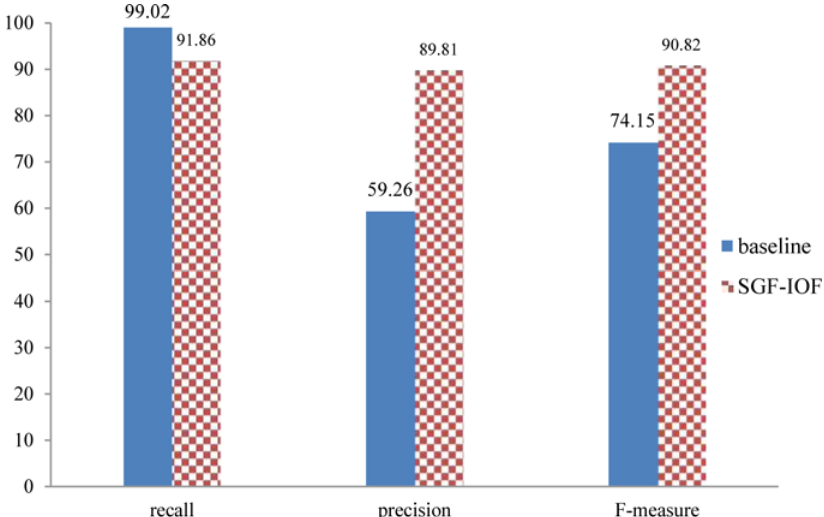
Fig 5. Comparison of the proposed method for detecting affected entities with the baseline